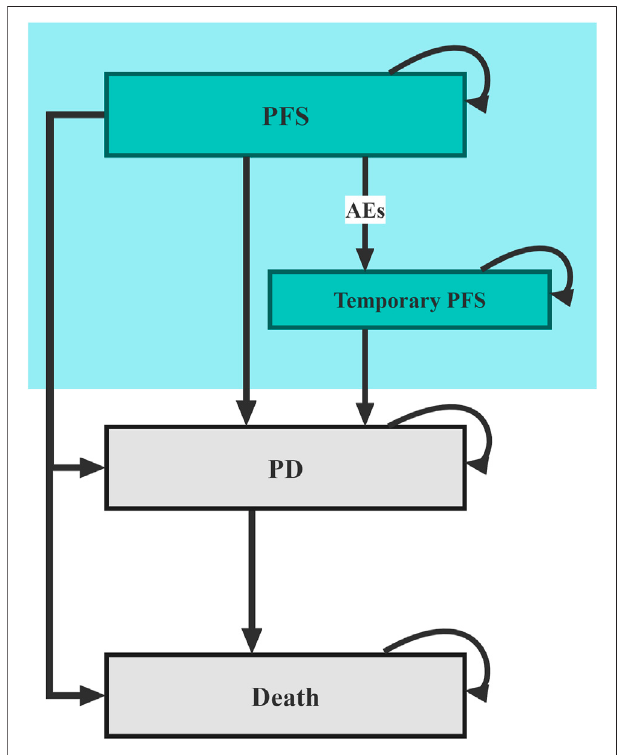
FIGURE 1 | Diagram of the Markov model. PFS, progression-free survival; PD, progressive disease; AE, adverse